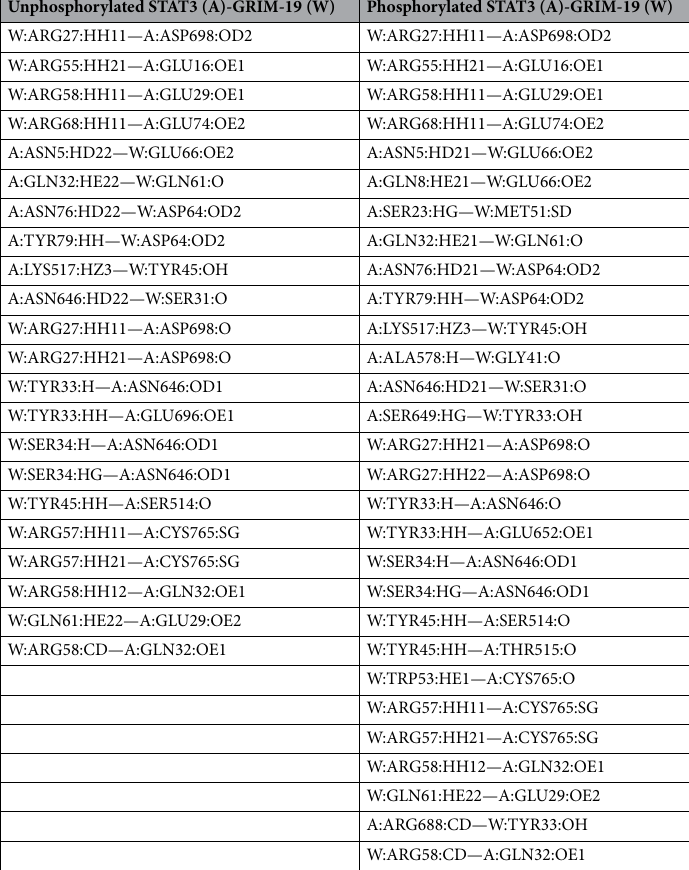
Table 1. I-TASSER-generated STAT3 structure: Hydrogen bond interactions between STAT3 and GRIM-19 complexes generated by